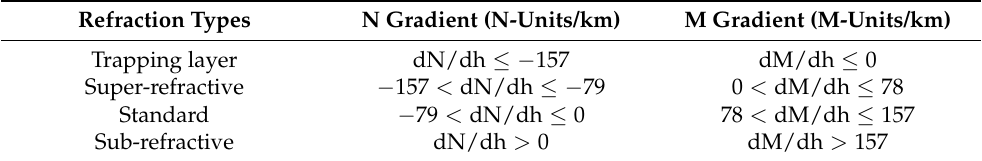
Table 1. The relationship between N gradient and M gradient in different refraction types. Refraction Types